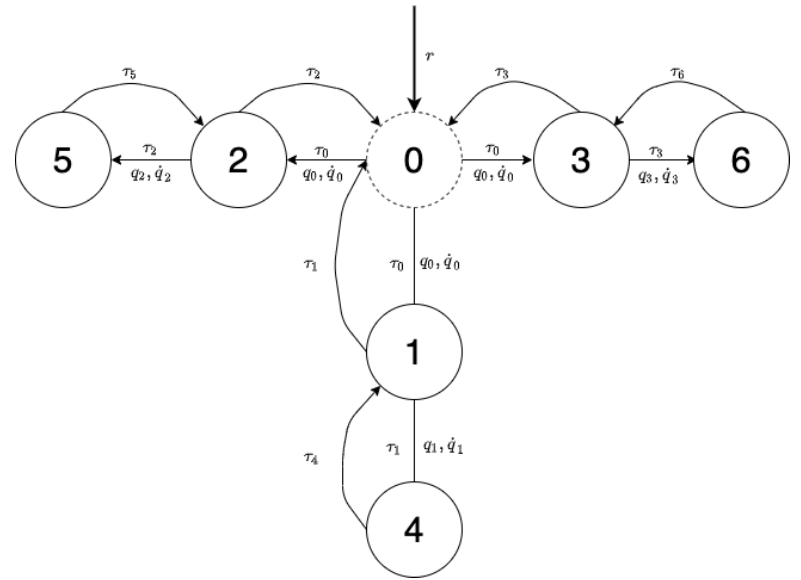
Figure 3. Communication graph of multi-agent